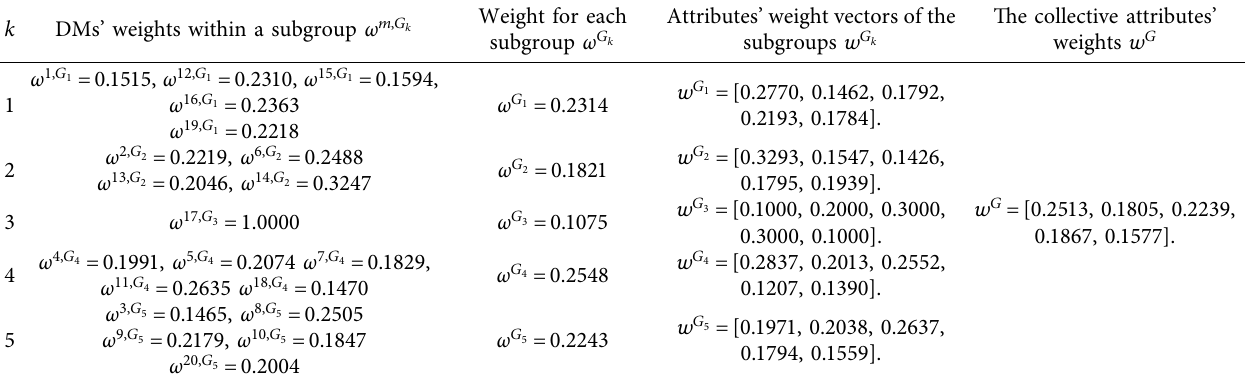
Table 14: .e final weights without considering the adjustment